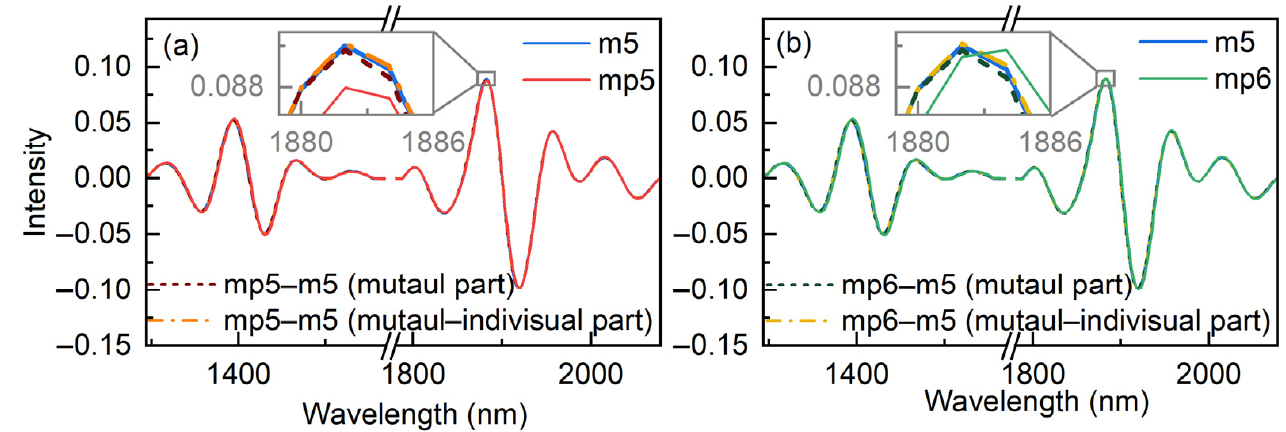
Figure 5. The transfer results for an arbitrarily selected spectrum from mp5 ( a ) and mp6 ( b ) to m5, respectively.